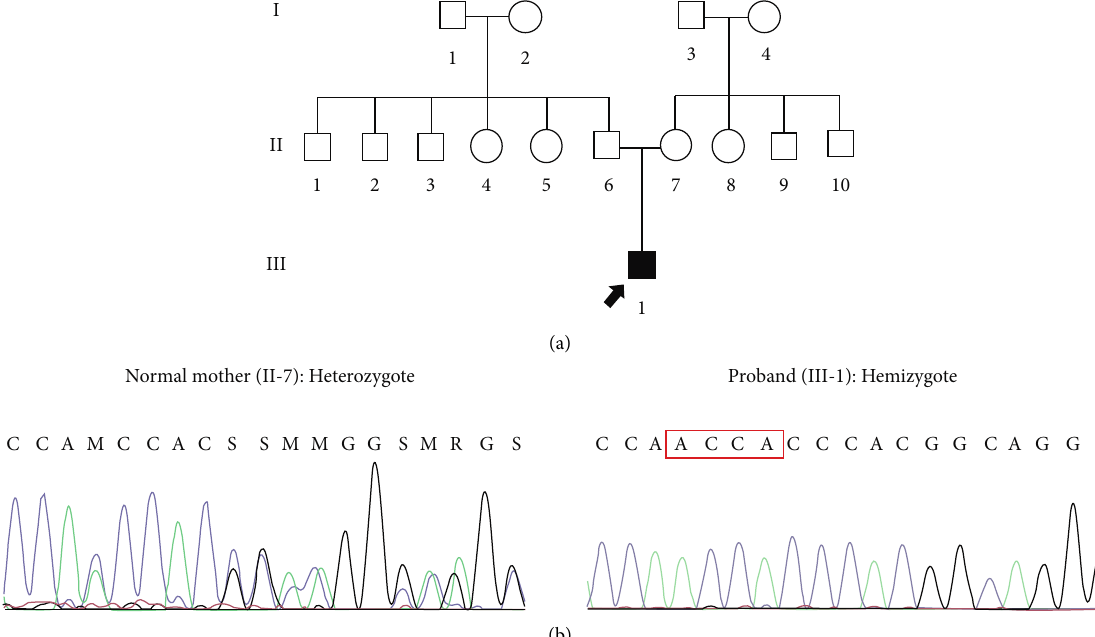
Figure 1: (a) Pedigree of the studied family with the patient denoted in black. (b) DNA sequence chromatograms indicate the inherited c.218_219insACCA: p.His73GlnfsTer41 variant in NR0B1 , encoding the nuclear receptor subfamily 0 group B member 1. Table 1: Biochemical analyses of the CAH patient blood Parameters (unit) Measured values in the patient Reference values